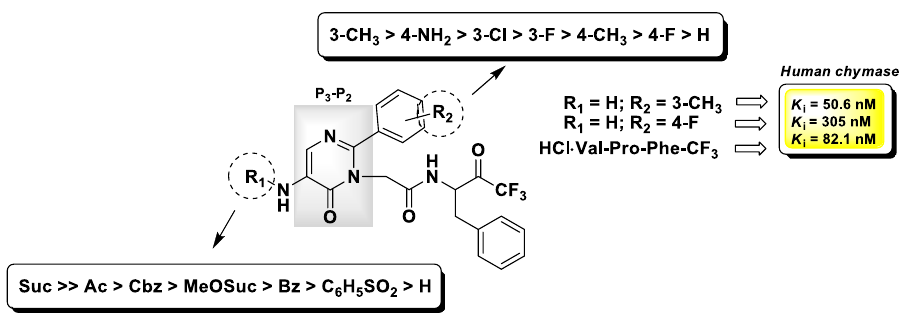
Figure 16. Chemical structure, partial SAR analysis, and K i values towards human chymase of the t-PFMKs developed by Akahoshi F. and co-workers.